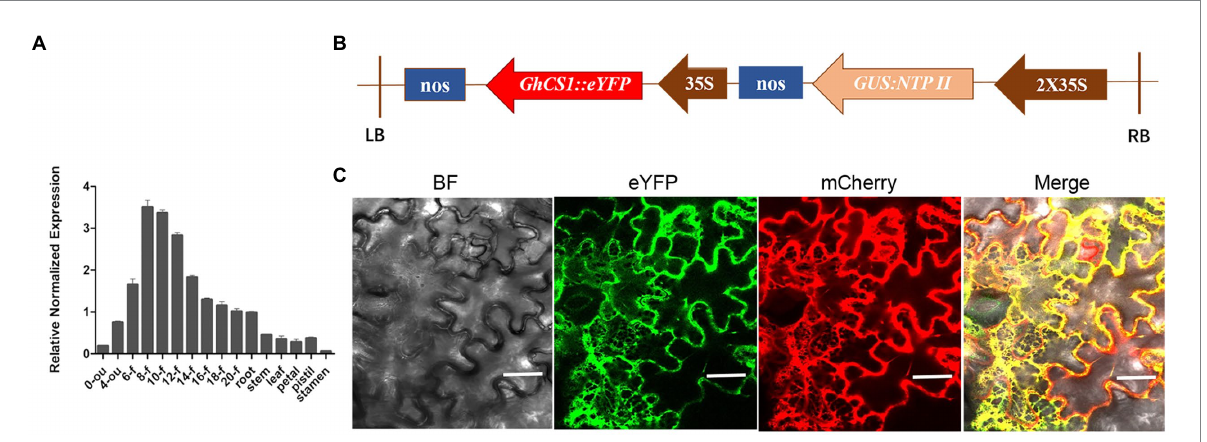
FIGURE 3 Expression pattern of GhCS1 and GhCS1 subcellular localization. (A) The expression pattern of GhCS1 . 0-ou and 4-ou: 0 DPA and 4 DPA ovules (with fiber cells); 6-f~20-f: The fiber cells of 6 to 20 DPA. Error bars represent the standard deviation (SD) of three independent replicate experiments. (B) The diagram of plant expression vector of GhCS1 ::eYFP fusion gene; (C) The subcellular location GhCS1::eYFP protein. BF: bright field; mCherry: HDEL::mCherry (HDEL is a marker protein of endoplasmic reticulum); eYFP: GhCS1::eYFP; Bar = 40